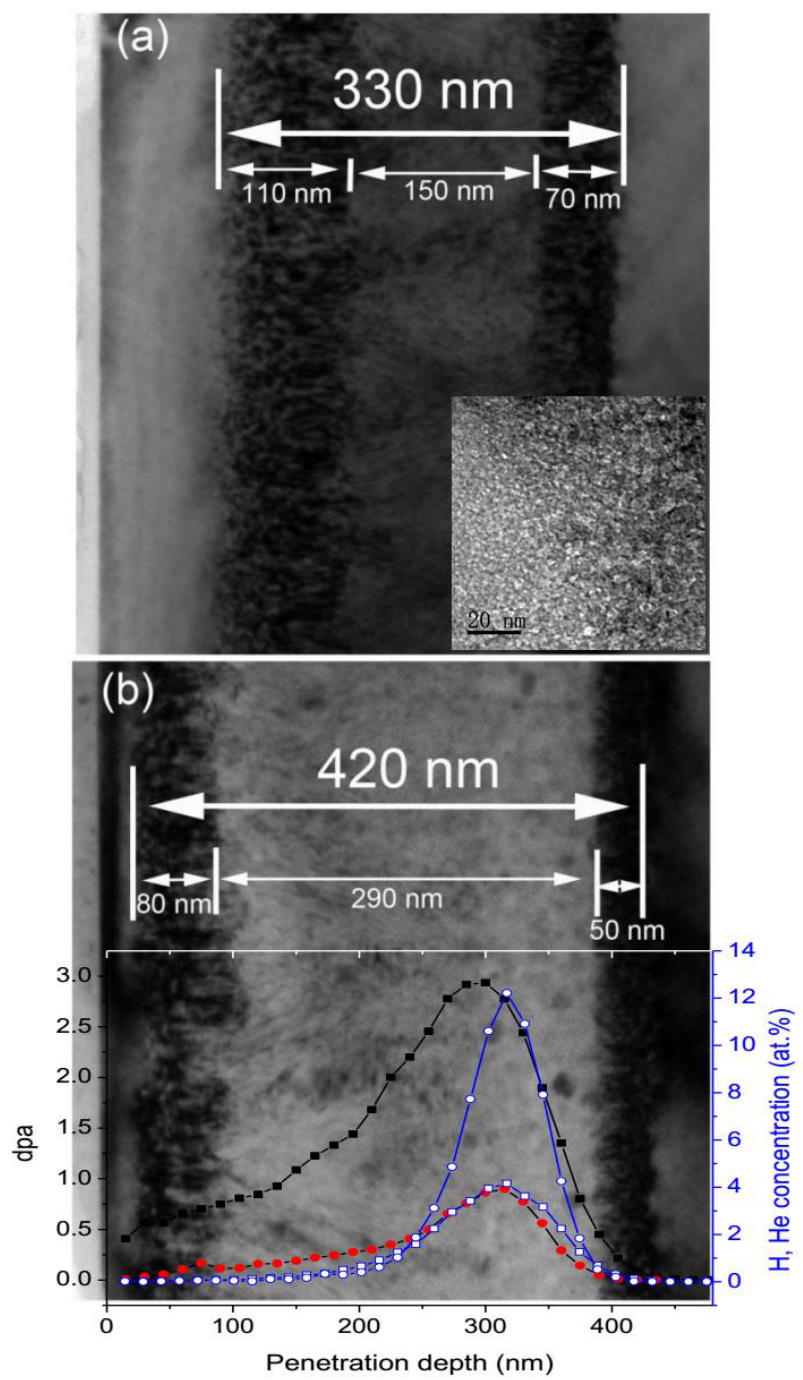
Figure 2. ( a ) XTEM bright-field micrographs of 6H-SiC implanted with the low fluence. ( b ) The high fluence, followed by annealing at 1100 °C for 15 min. Inset in ( a ) taken from the middle of the damaged layer was observed under the under-focused condition. In ( b ) are superposed with SRIM-2013 simulation the profiles of irradiation damages (solid) and atom concentrations (open) (squares for He implantation at a fluence of 5 × 10 16 He + /cm 2 and circles for H 2+ implantation at a fluence of 5 × 10 16 H 2+ /cm 2 ).